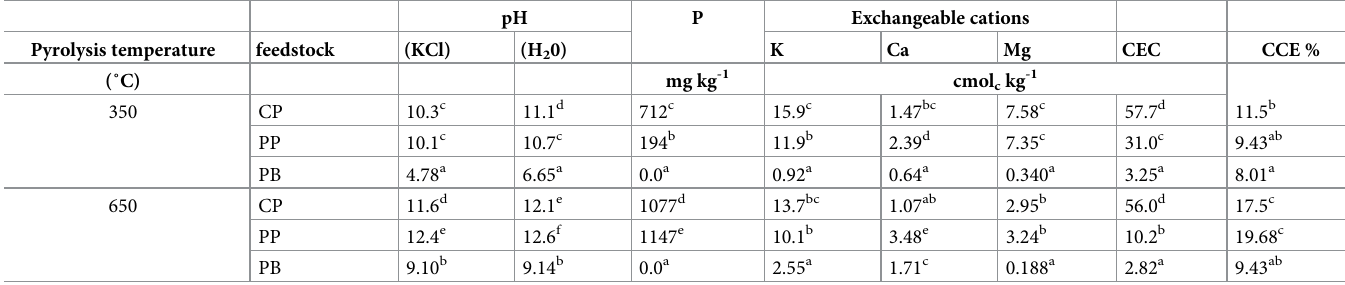
Table 5. Selected chemical properties of the biochar types.